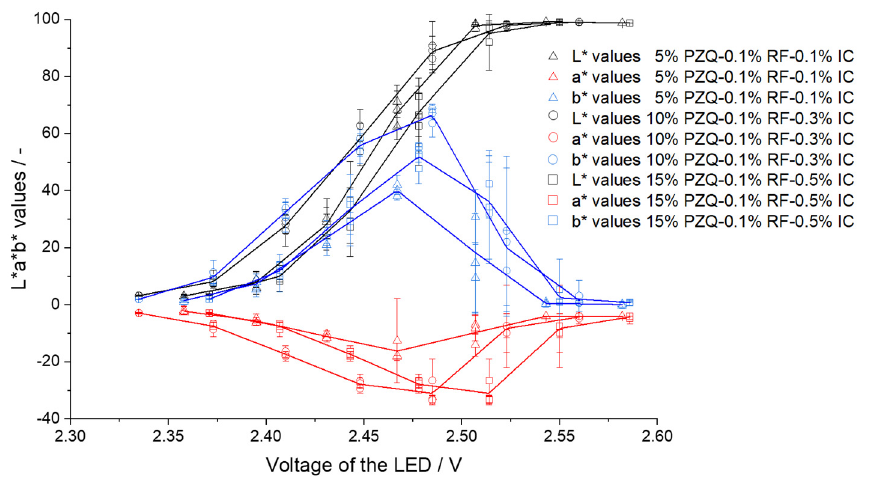
Figure 9. a* and b* values depending on LED voltage for the filaments of PZQ with different concentrations of RF and IC (VA-5% PZQ-0.1% RF-0.1% IC, VA-10% PZQ-0.1% RF-0.3% IC and VA-15% PZQ-0.1% RF-0.5% IC).